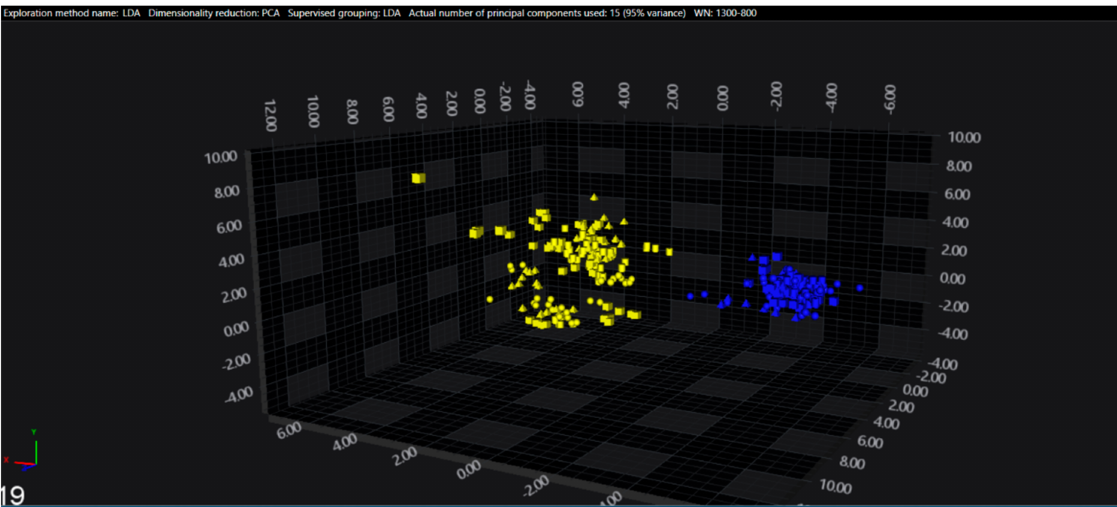
Figure 7. LDA of the O:7 serogroup (blue = Paratyphi C, yellow = other serovars).